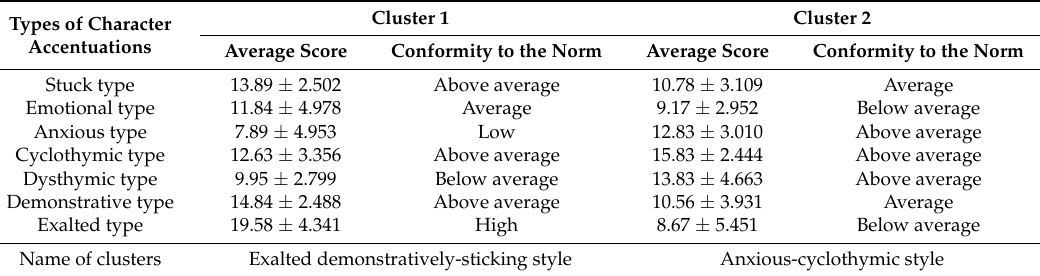
Table 4. Severity of character accentuations in workers of two